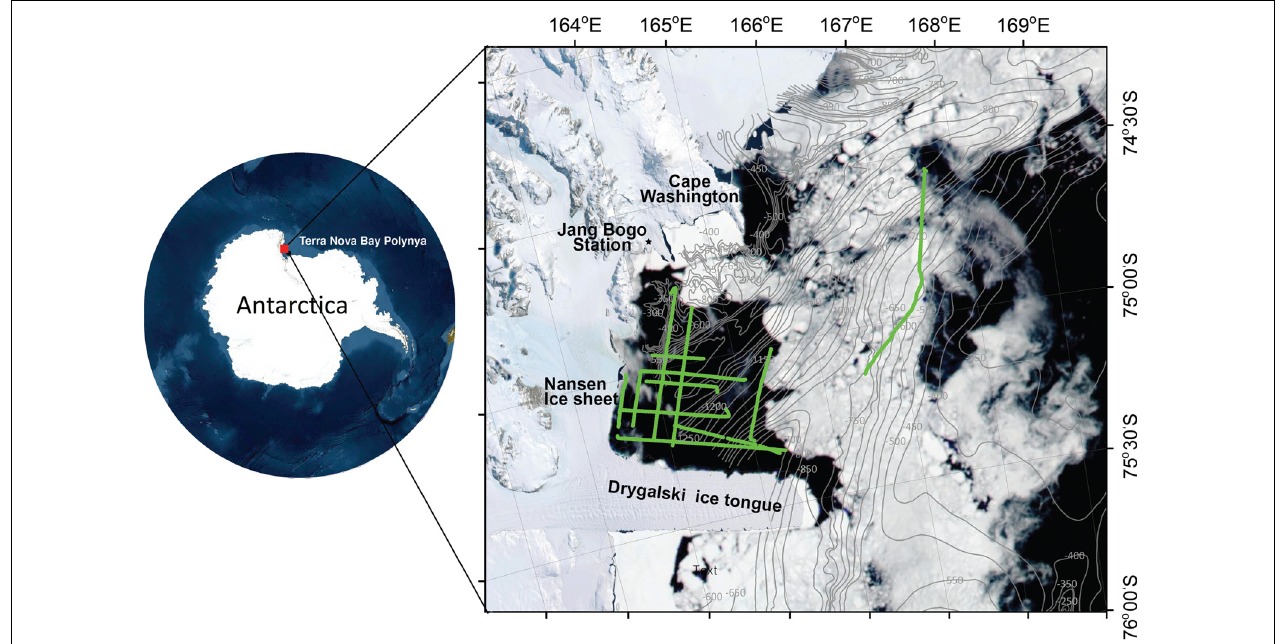
FIGURE 1 | The study area off the Terra Nova Bay polynya, Ross Sea, Antarctica, conducted on 7–14 January 2019. The green line indicates the cruise track line. The gray line with numbers is the bathymetric contour (Davey, 2013). Sea ice distribution, which was from Moderate Resolution Imaging Spectroradiometer (MODIS) on NASA’s Aqua satellite on January 4, 2019, is